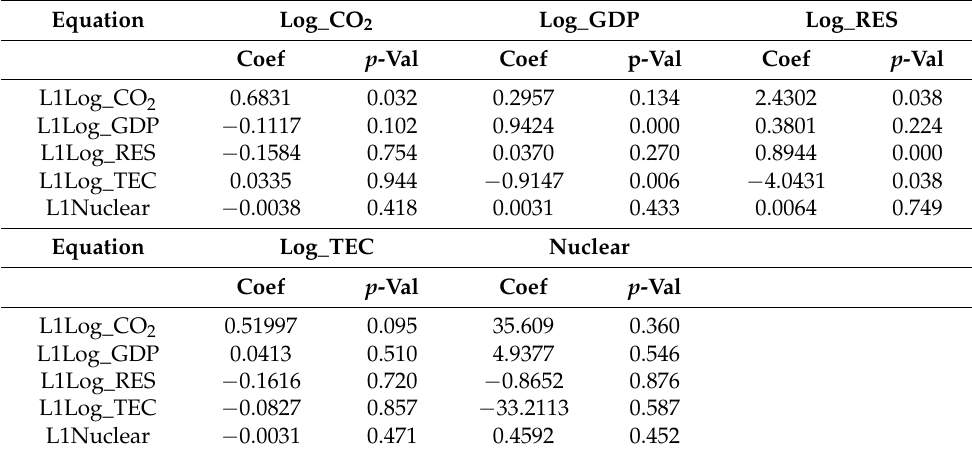
Table 6. Result of first-order panel VAR model estimation in the GMM FD